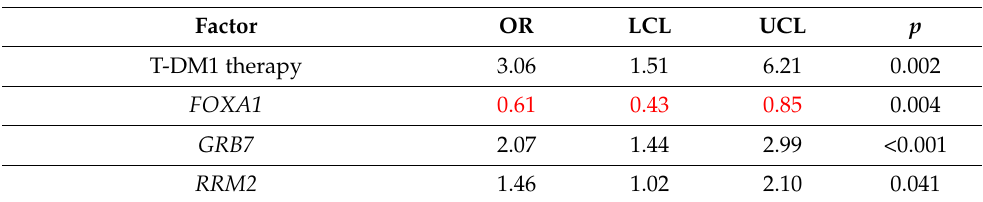
Table 5. Adjusted standardized ORs of genes, including therapy variable, with significant impact on pCR in multivariable logistic regression models. All 53 gene expression levels and PAM50 subtypes were entered. Significant ORs ≤ 1 are shown in red; ORs > 1 are shown in black. Abbreviations as above. Entire Gene Expression Population with pCR Multivariable pCR Including Therapy Endpoint ( N = 240)